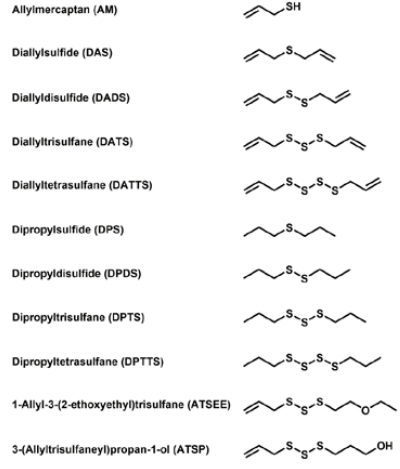
Figure 1. Names, abbreviations and chemical structures of the various sulfur compounds selected